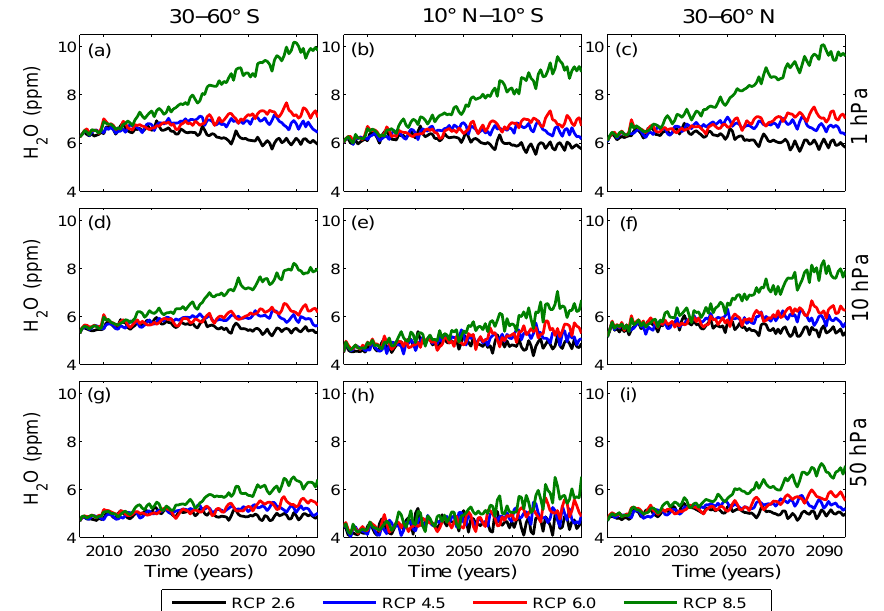
Figure 7. SWV in the four RCP simulations for the same regions shown in Fig.